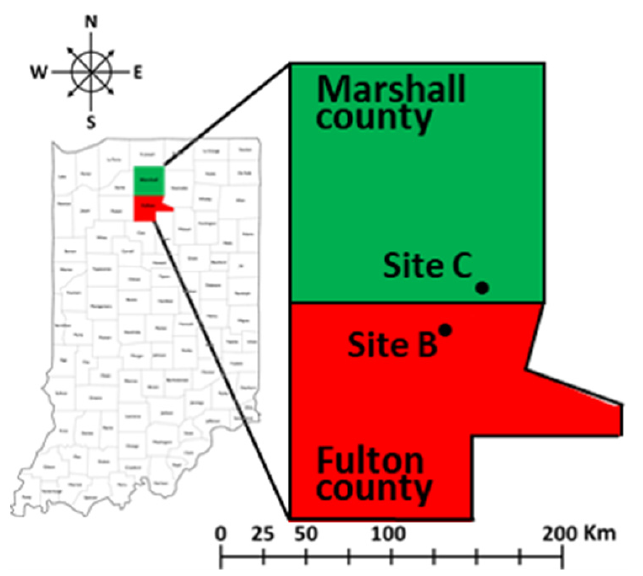
Figure 1. Site locations. Illustration of the relative distance between the Site B and Site C study sites.